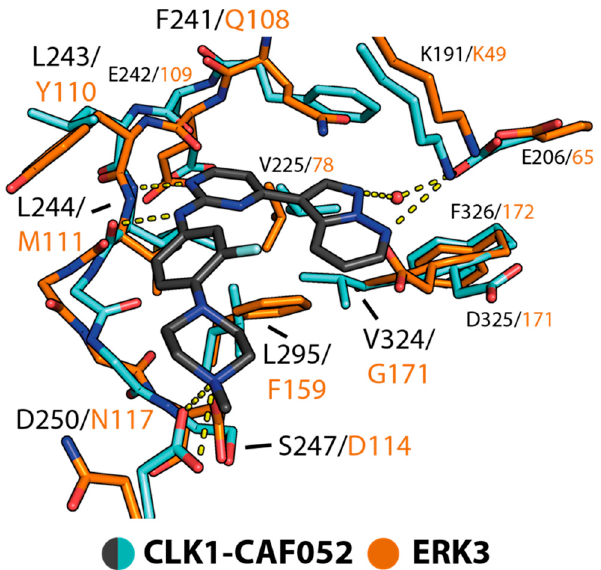
Figure 4. Structural comparison of binding of CAF052 in CDC-like kinase 1 (CLK1) and ERK3. Superimposition of the CLK1–CAF052 complex (PDB 7ak3) and ERK3 suggests potentially similar binding modes of the inhibitor in both kinases. Contacts observed between the inhibitor and CLK1 are shown with yellow dashed lines.